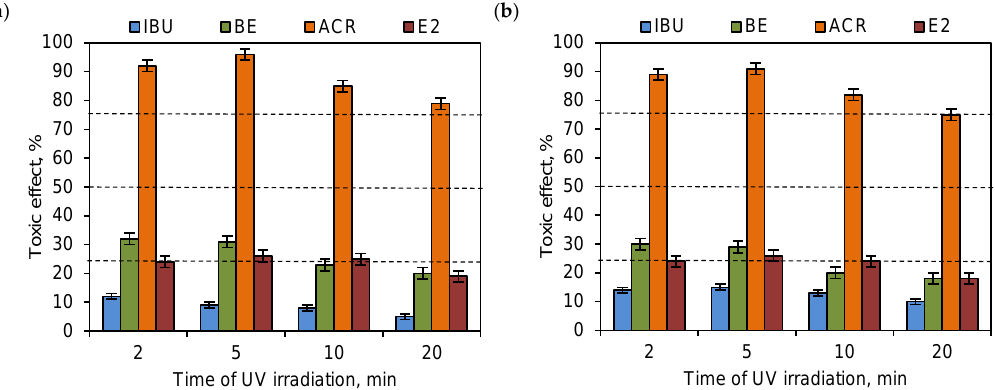
Figure 10. Change in the toxicity of ( a ) deionized water and ( b ) surface water solution after single chlorination (30 min) and the addition of CECs (dashed lines indicate the boundaries between the toxicity classes).